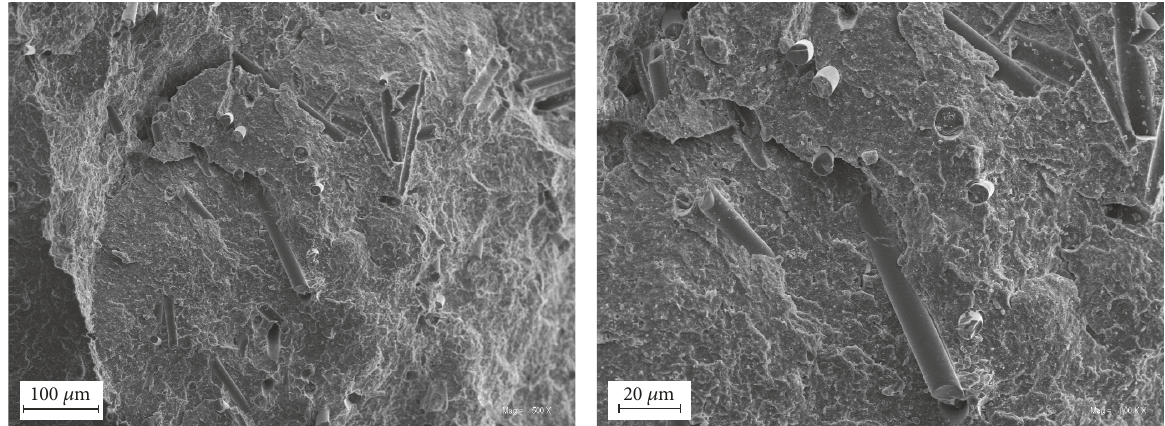
Figure 14: SEM image of the cryogenic fracture of a PVC/10% GFCD